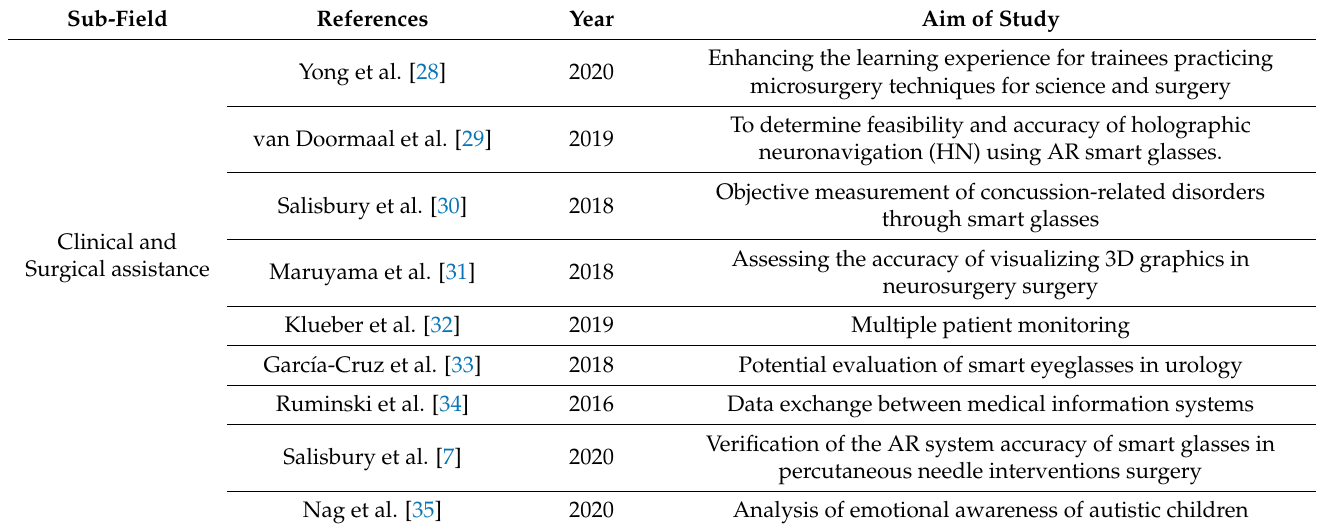
Figure 7. Location of user study: renovated office area with available building information modeling data regarding the building itself as well as the furniture. Top , real furniture after the renovation; bottom , augmented reality visualization during construction [27]. Table 2. Summary of smart glass applications in the field of